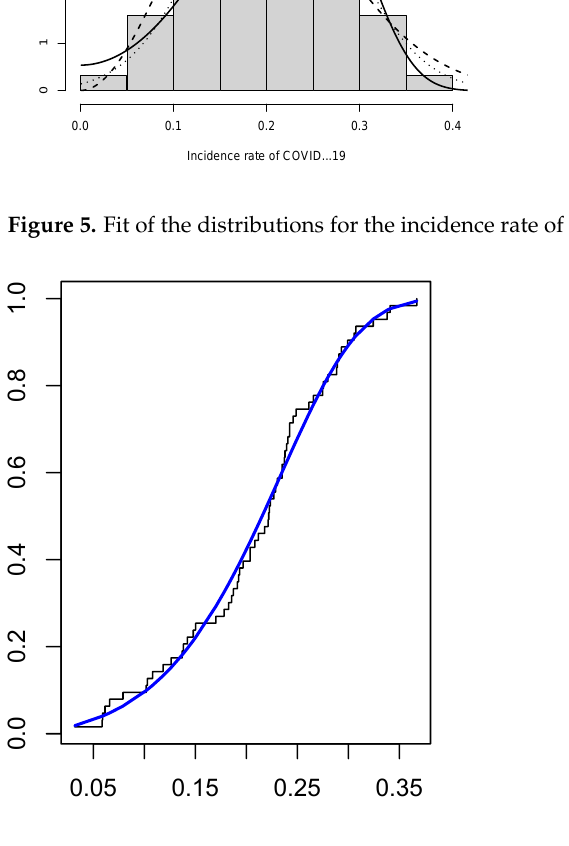
Figure 6. Empirical (black) and fitted EHPE (blue) cdf for the incidence rate of COVID-19 in dataset